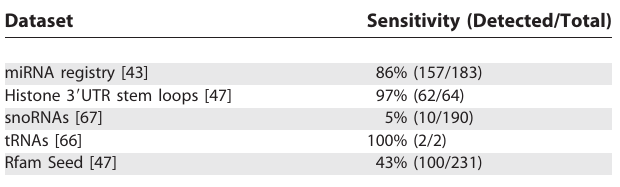
Table 1. EvoFold Sensitivity Dataset